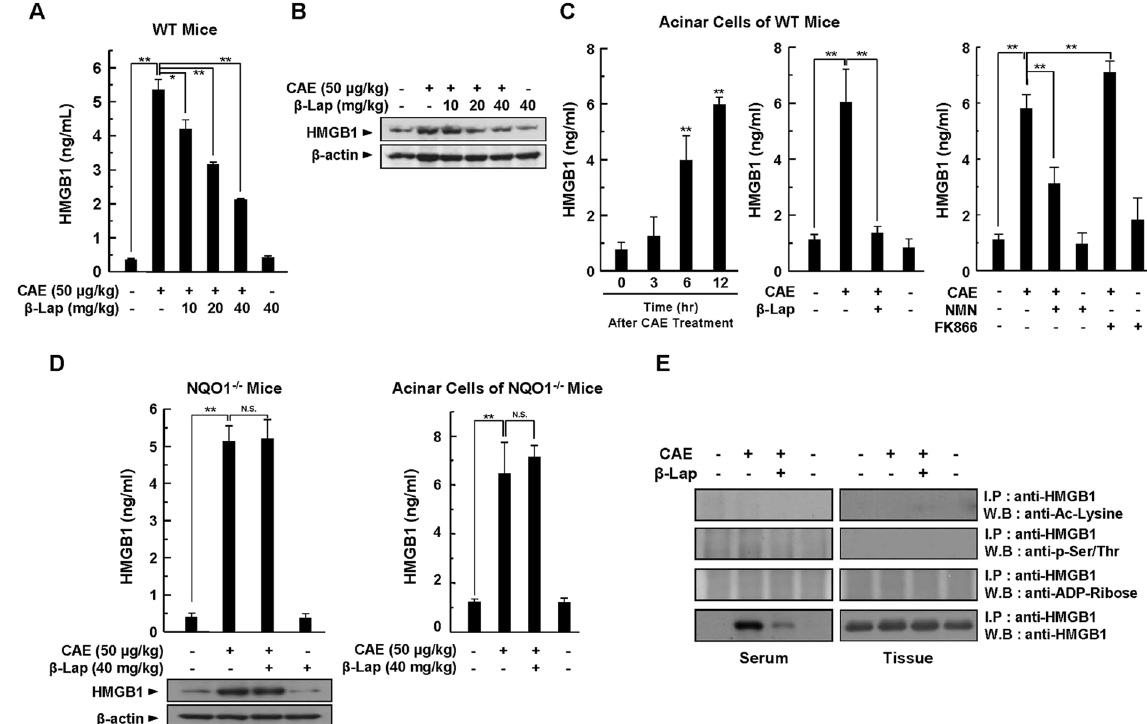
Figure 5. Effect of β -Lap on HMGB1 expression and extracellular secretion during caerulein-induced AP. ( A ) Serum levels of HMGB1 were determined by ELISA. ( B ) Pancreatic HMGB1 protein expression was determined by western blotting in WT mice. ( C ) Isolated acinar cells in WT mice were treated with caerulein (1 μ M) with or without β -Lap (1 μ M), NMN (100 μ M), and FK866 (1 μ M) for 24, and then extracellular HMGB1 levels were determined by ELISA. ( D ) Pancreatic HMGB1 protein expression was determined by western blotting in NQO1 − / − mice. HMGB1 release in serum and isolated primary acinar cells from NQO1 − / − mice was determined by ELISA. ( E ) Post‐translational modification of HMGB1 protein in serum or the pancreatic tissues of caerulein-injected WT mice was determined by western blotting. * P < 0.05, ** P <